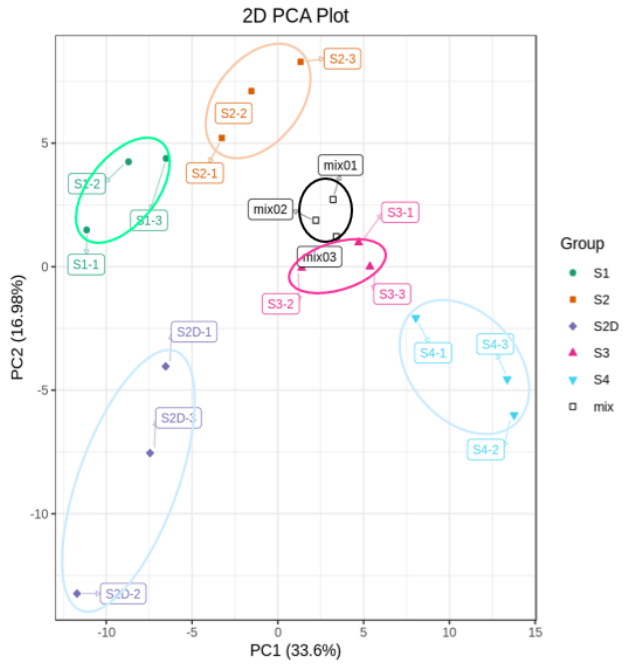
Figure 2. Principal component analysis (PCA) of flavonoid metabolites profiles analysis.